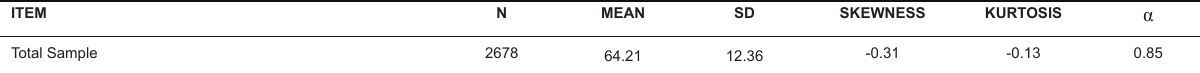
TABLE 4 Descriptive statistics and Cronbach’s alpha coeffient of the 13-iterm